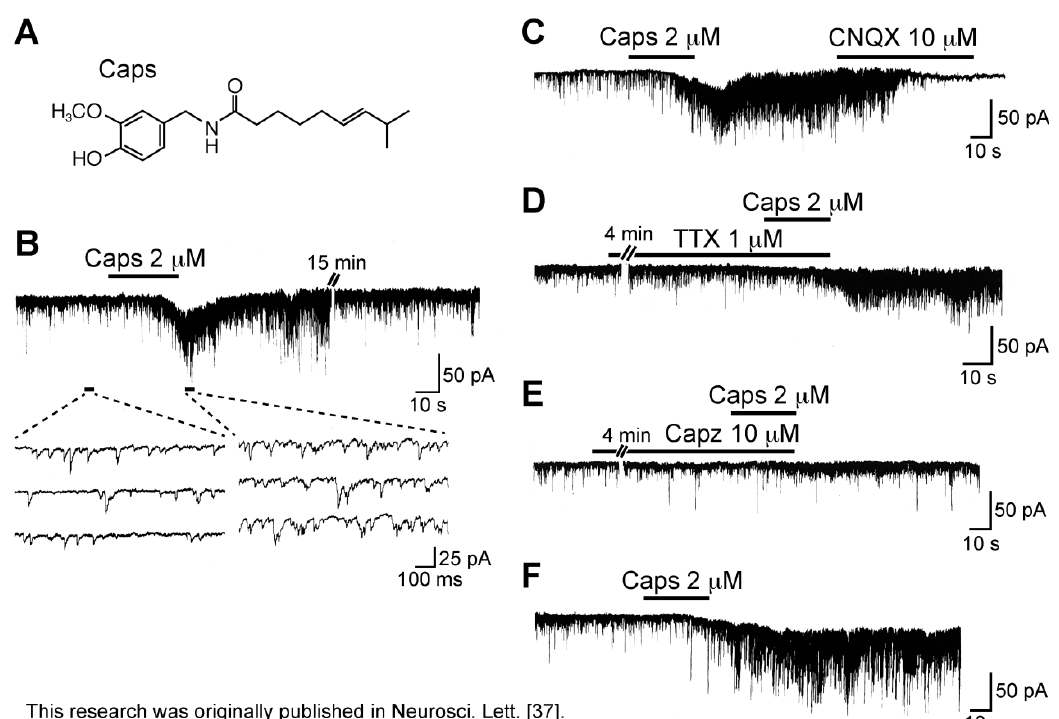
Figure 2. Capsaicin (Caps; 2 µM) increases the frequency of spontaneous excitatory postsynaptic current (EPSC) and produces an inward current in rat substantia gelatinosa (SG) neurons by activating TRPV1 channels. ( A ) The chemical structure of Caps; ( B ) Recordings of spontaneous EPSCs (sEPSCs) before and under the action of Caps. In this and subsequent figures, the horizontal bar above the chart recording indicates the period of time during which the drug was applied, and 3–4 consecutive traces of sEPSCs for a period indicated by a short bar below the recording are shown in an expanded time scale; ( C ) Action of a non-NMDA receptor antagonist CNQX (10 µM) on a barrage of sEPSCs under the action of Caps; ( D ) The sEPSC frequency increase produced by Caps is unaffected by a voltage-gated Na + -channel blocker tetrodotoxin (TTX; 1 µM); ( E ) Action of Caps in the presence of a TRPV1 antagonist capsazepine (Capz; 10 µM); Note that the sEPSC frequency increase as well as inward current were markedly attenuated by Capz; ( F ) Caps action at 15 min after washout of Capz, where sEPSC frequency was increased and an inward current lasting for 3 min (shown partly) was induced; this was obtained from the same neuron as that in ( E ). Holding potential (V ) was −70 mV. Modified from [37] H with permission of Elsevier